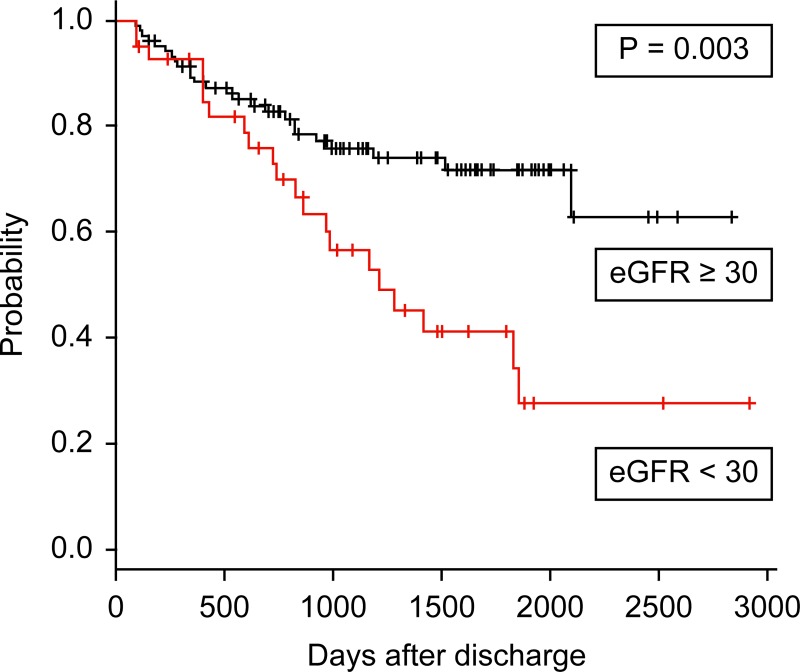
Kaplan-Meier survival curves depicting the period between discharge and the composite endpoint of death and chronic dialysis initiation.Association between estimated glomerular filtration rate (eGFR) ≥ or <30 mL/min/1.73 m2 at hospital discharge and composite endpoint.